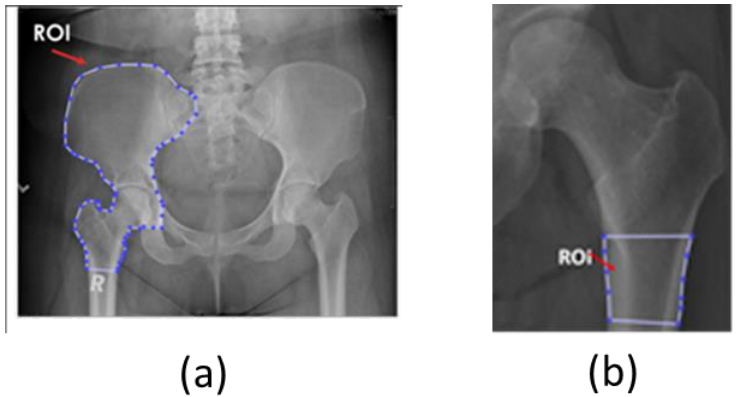
Figure 2. Examples of ROI selection for attribute index calculation at ( a ) pelvic, and ( b ) hip locations.